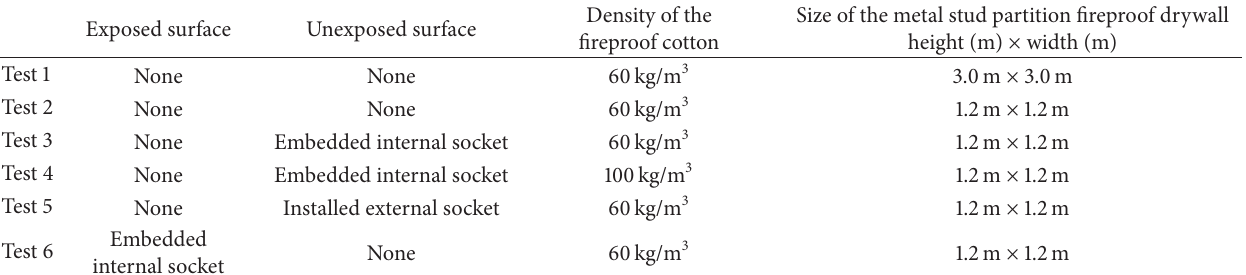
Table 1: Test specimen standard.